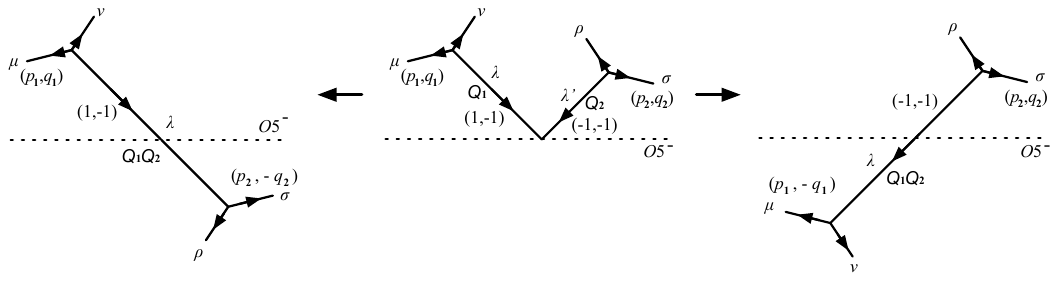
Figure 10 . The web diagram to which the O 5 -plane factor is assigned and its partial